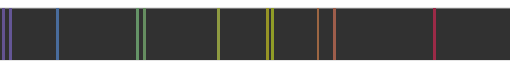
that appears on a screen. The spectrum is obtained by using a and a glass prism.